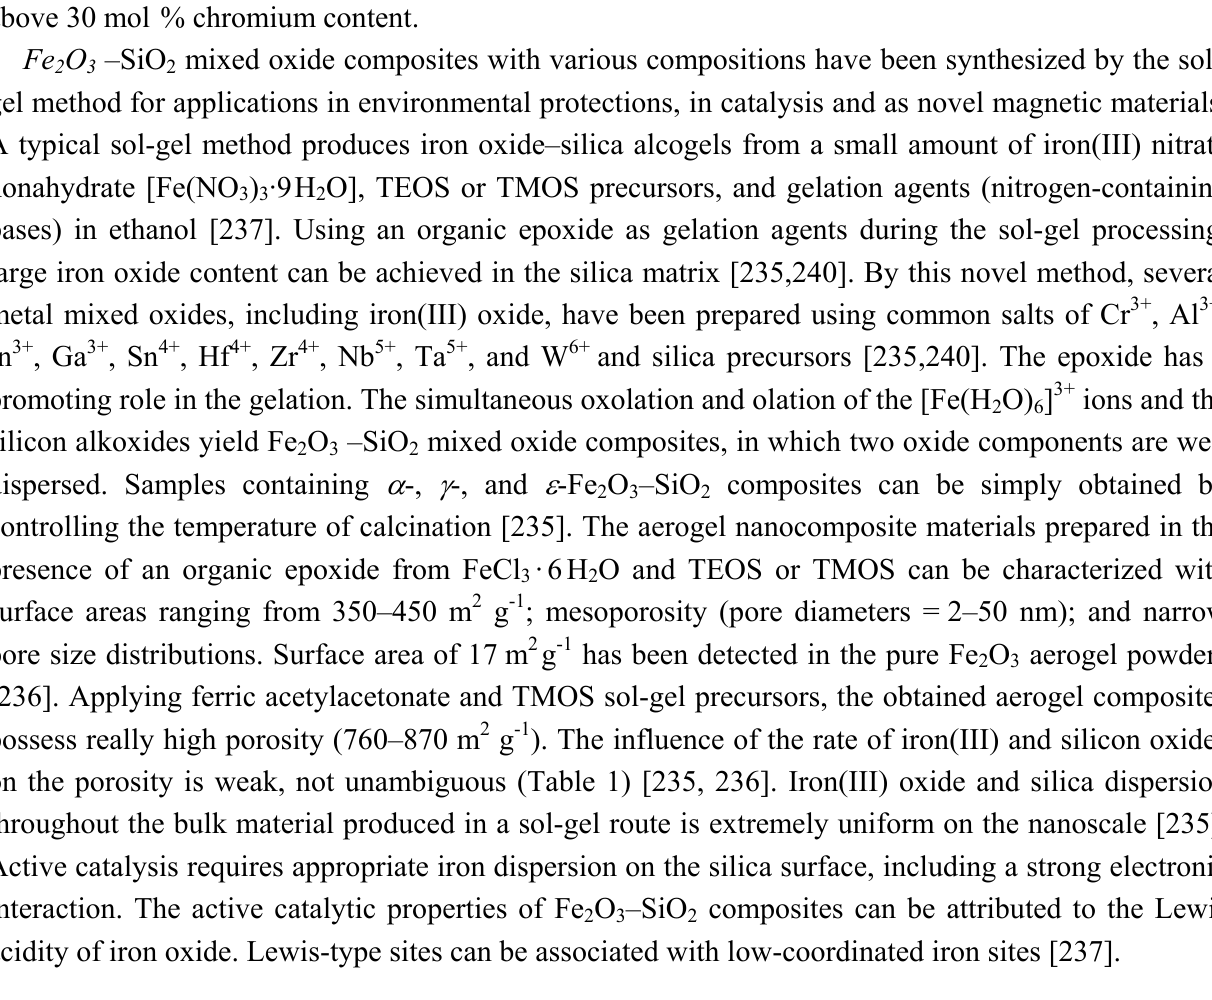
Table 1. Influence of metal ions on silicate